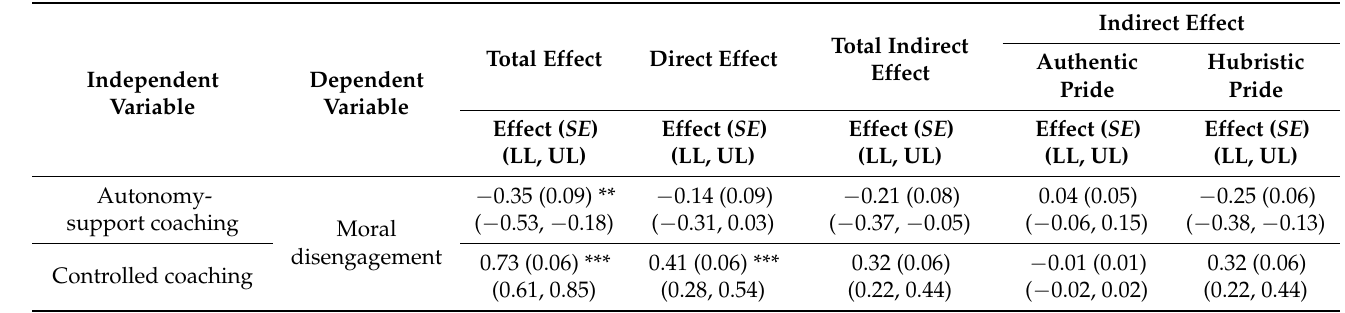
Table 2. Direct and Indirect Effects of Coaching Type, Pride, and Moral